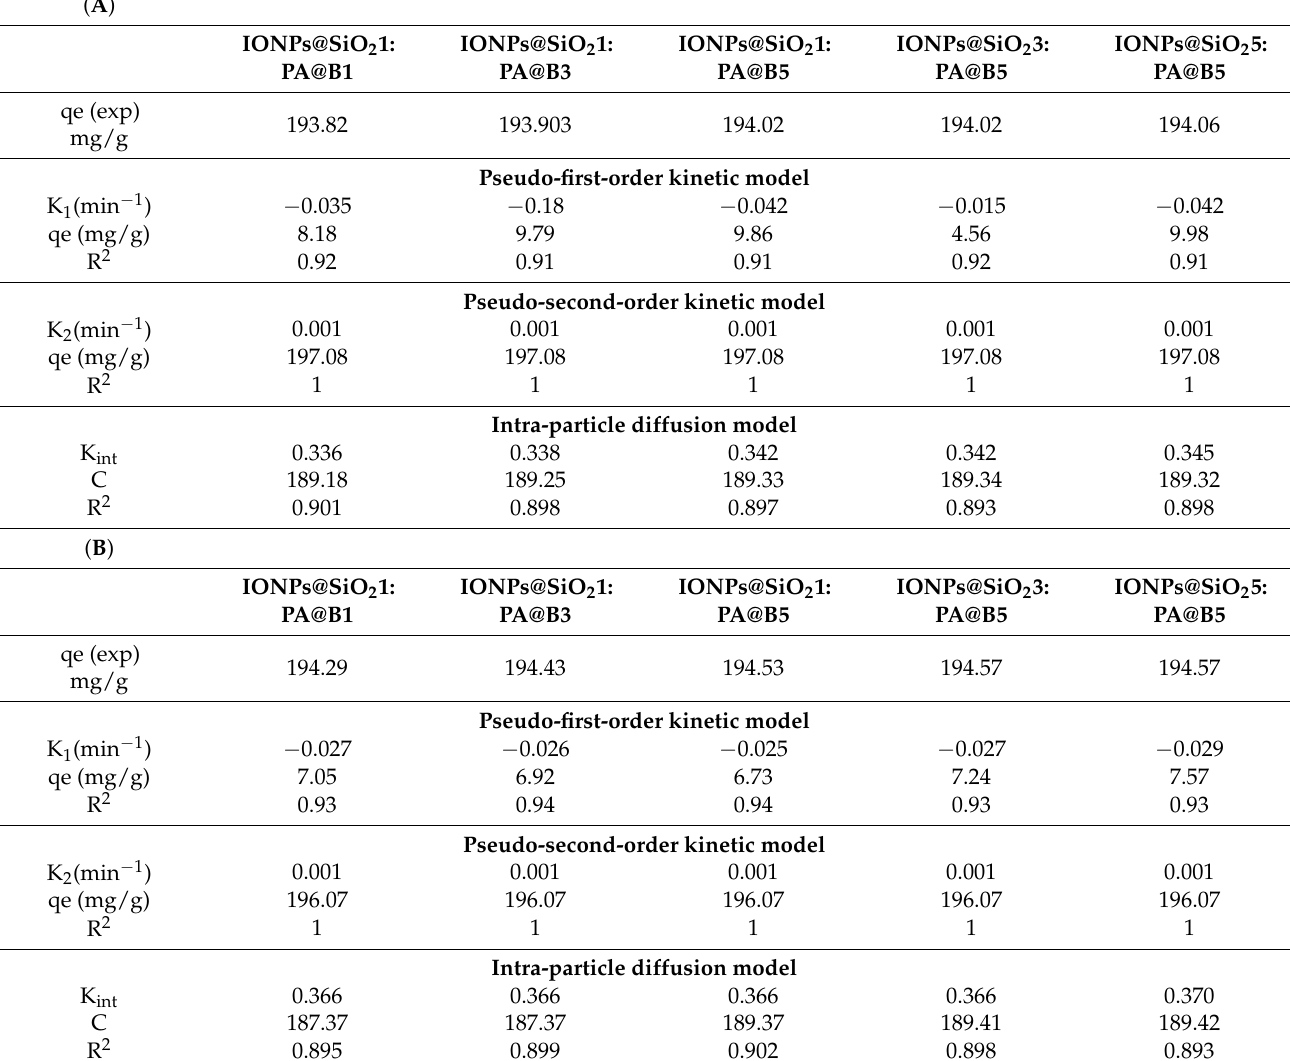
Table 2. ( A ). Kinetic models for loading of aprepitant into the fabricated IONPs@SiO 2 -PA@B com- posite materials. ( B ). Kinetic models for the loading of sofosbuvir into the IONPs@SiO 2 -PA@B composite